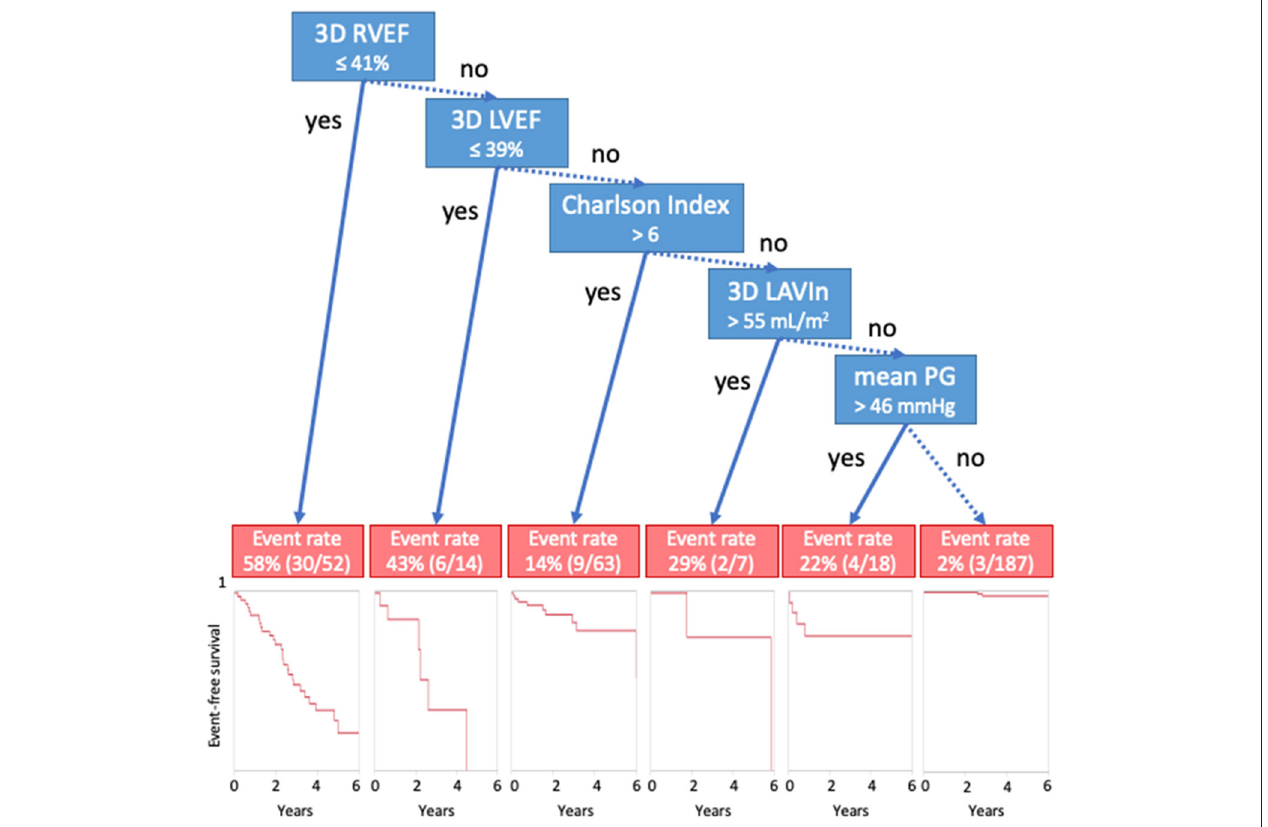
FIGURE 3 | Classification and regression-tree analysis for cardiac events. Blue boxes denote cut-offs, and red boxes describe event rates. 3D, three-dimensional; AVR, aortic valve replacement; LAVIn, minimum left atrial volume index; LVEF, left ventricular ejection fraction; PG, pressure gradient; RVEF, right ventricular ejection